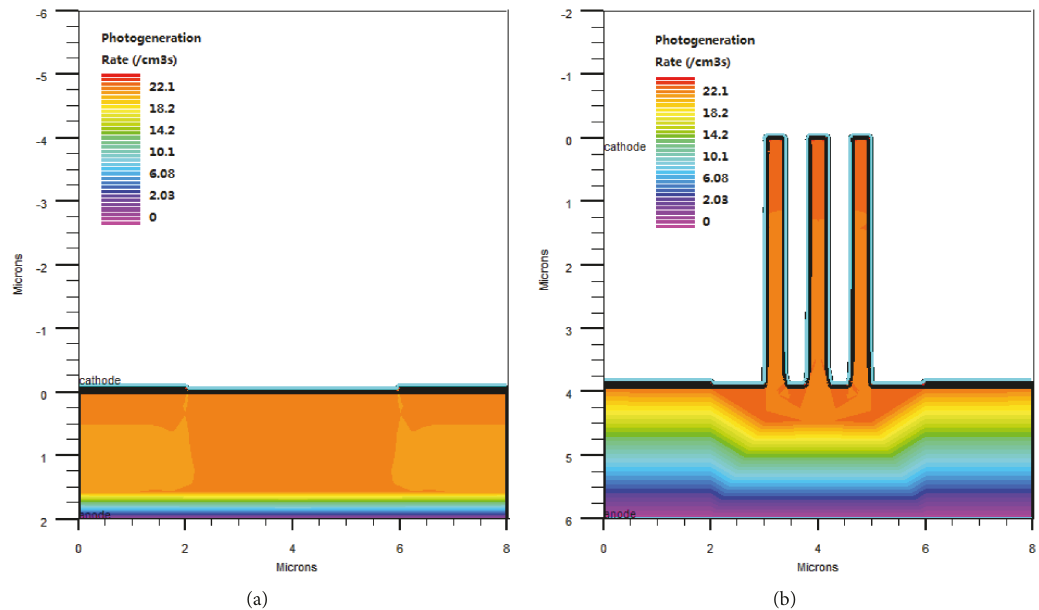
Figure 3: Photogeneration rate of silicon based solar cell ( a ) planar p-n junction on 2 𝜇 m thick substrate; ( b ) radial core-shell junction with 4 𝜇 m length nanowires on 2 𝜇 m thick substrate.